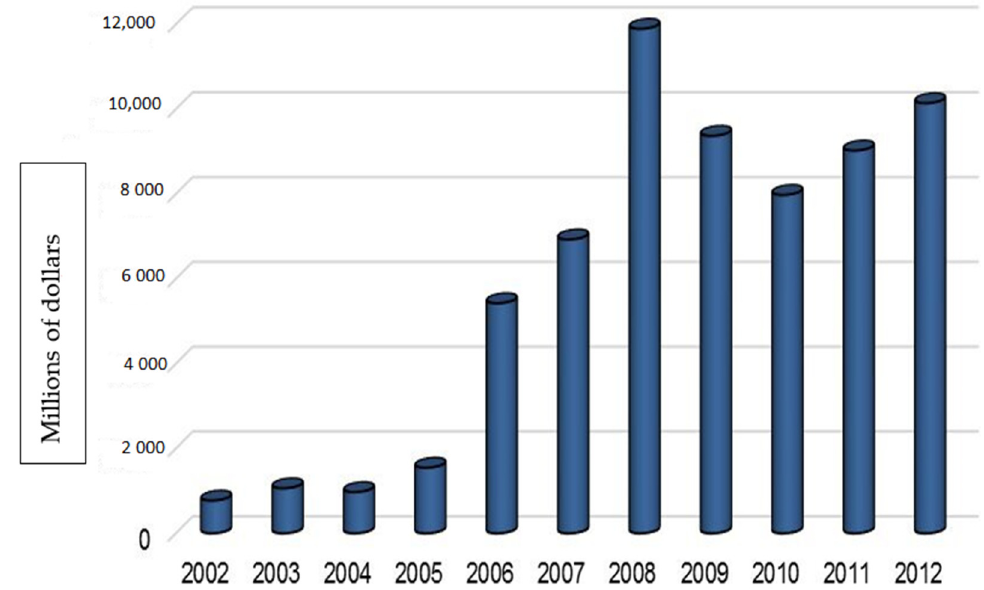
Figure 8. Public investments in Angola. Source: CEIC Report (CEIC 2013).